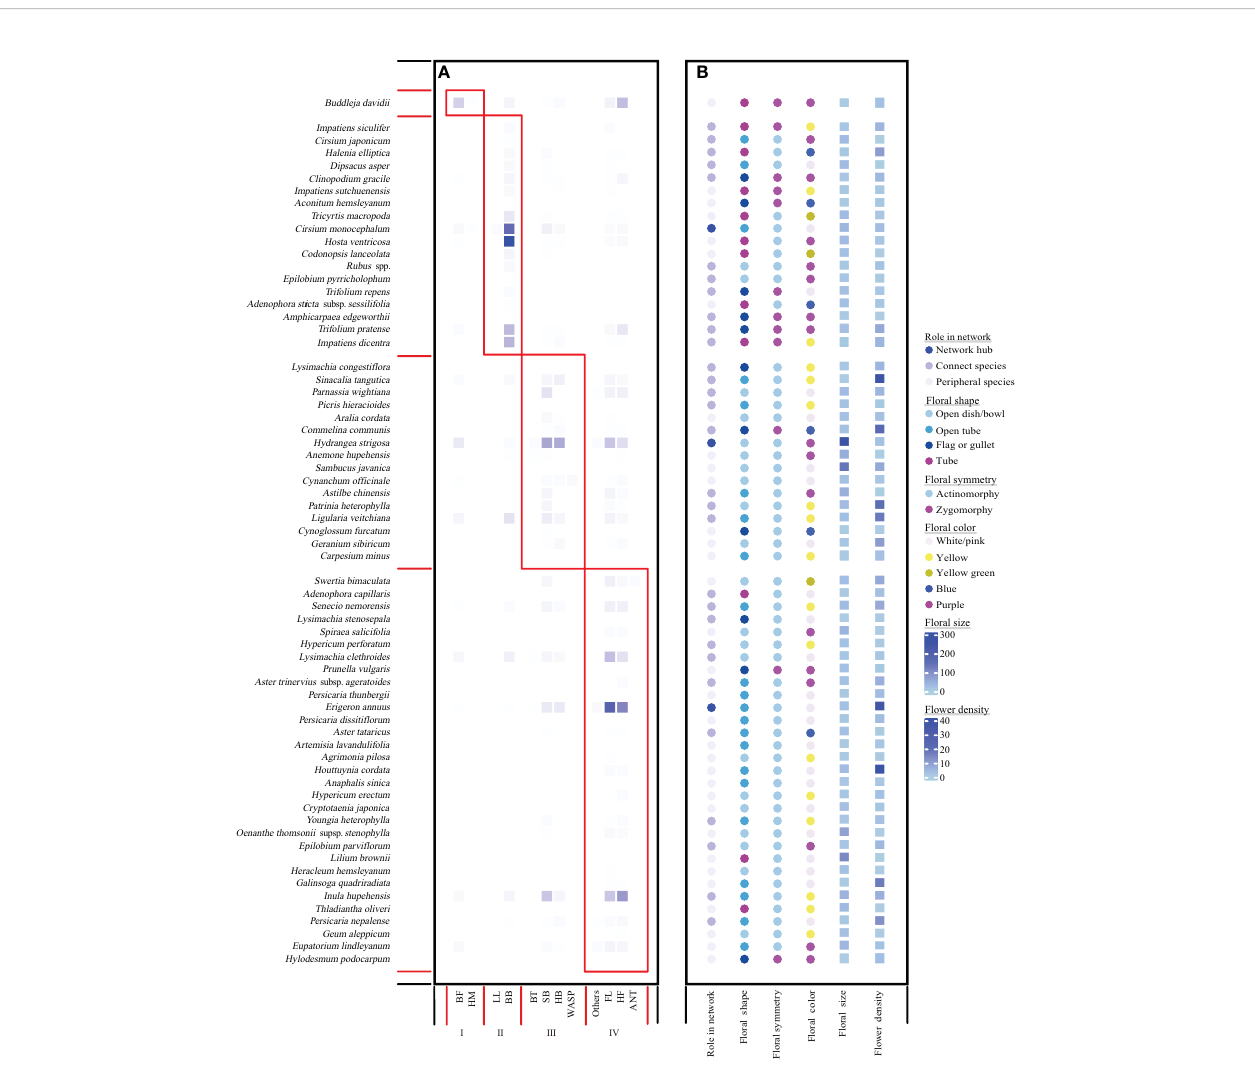
FIGURE 1 Network modular structure (A) with plant species ’ roles in the network and fl oral traits as shown in (B) . (A) Four modules delineated by red boxes, which was calculated using computeModules functions in the R package “ bipartite ” . The color intensity indicates the interaction frequency between partners. Species are sorted according to their modular af fi nity; plants as rows and pollinators as columns. (B) Role in network of each species, and their fl ower density, fl oral size, fl oral shape were shown as different color. The heatmap of fl ower density and fl oral size was drawn using the package “ complexHeatmap ” (Gu et al., 2016) in R